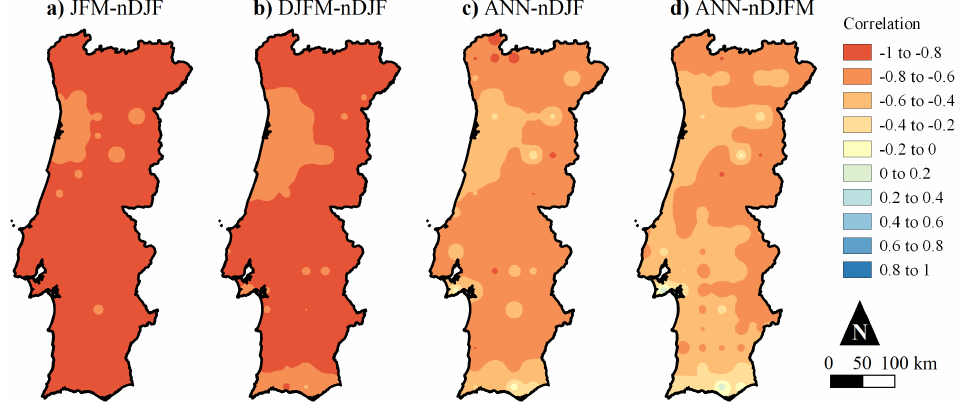
Figure 6. Teleconnection between the grid-point rainfall trends and NAOI trends from 1919–2019. Spatial distribution of the Pearson correlation coefficient, r , between the progressive-trend series, u ( t ) , of JFM-nDJF, DJFM-nDJF, ANN-nDJF, and ANN-nDJFM (IDW2 interpolation method used for